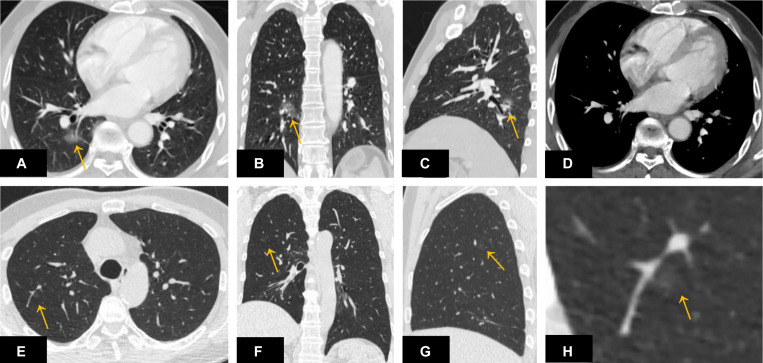
A ground-glass nodule (A–D) located close to the right hilum and surrounding the pulmonary vasculature was missed by DL-CADx. Another ground-glass nodule (E–H) smaller than 1 cm in diameter and attached to the pulmonary vasculature in the right upper lobe was missed by DL-CADx.